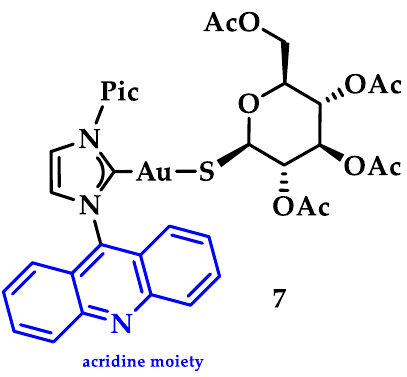
Figure 15. Chemical structure of acridine-based thiolate Au(I)-NHC .